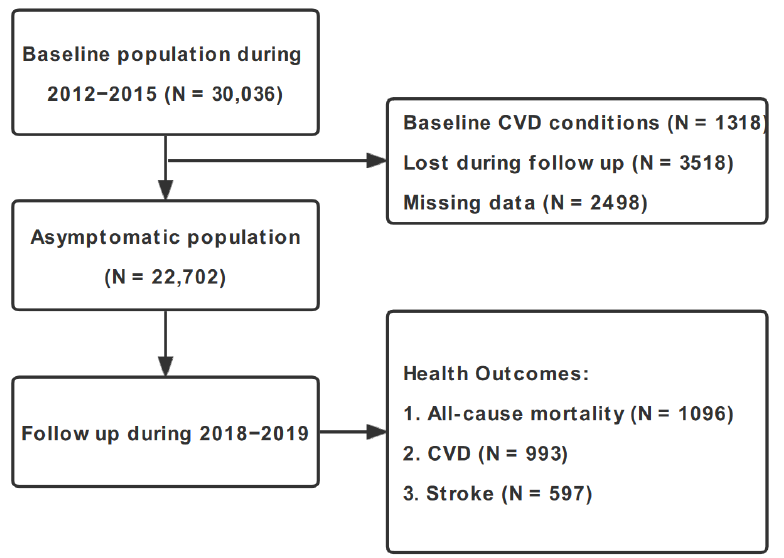
Figure 1. Flow diagram of inclusion and exclusion of CHS cohort participants. Abbreviations: CVD, cardiovascular disease; CHS, China Hypertension Survey.